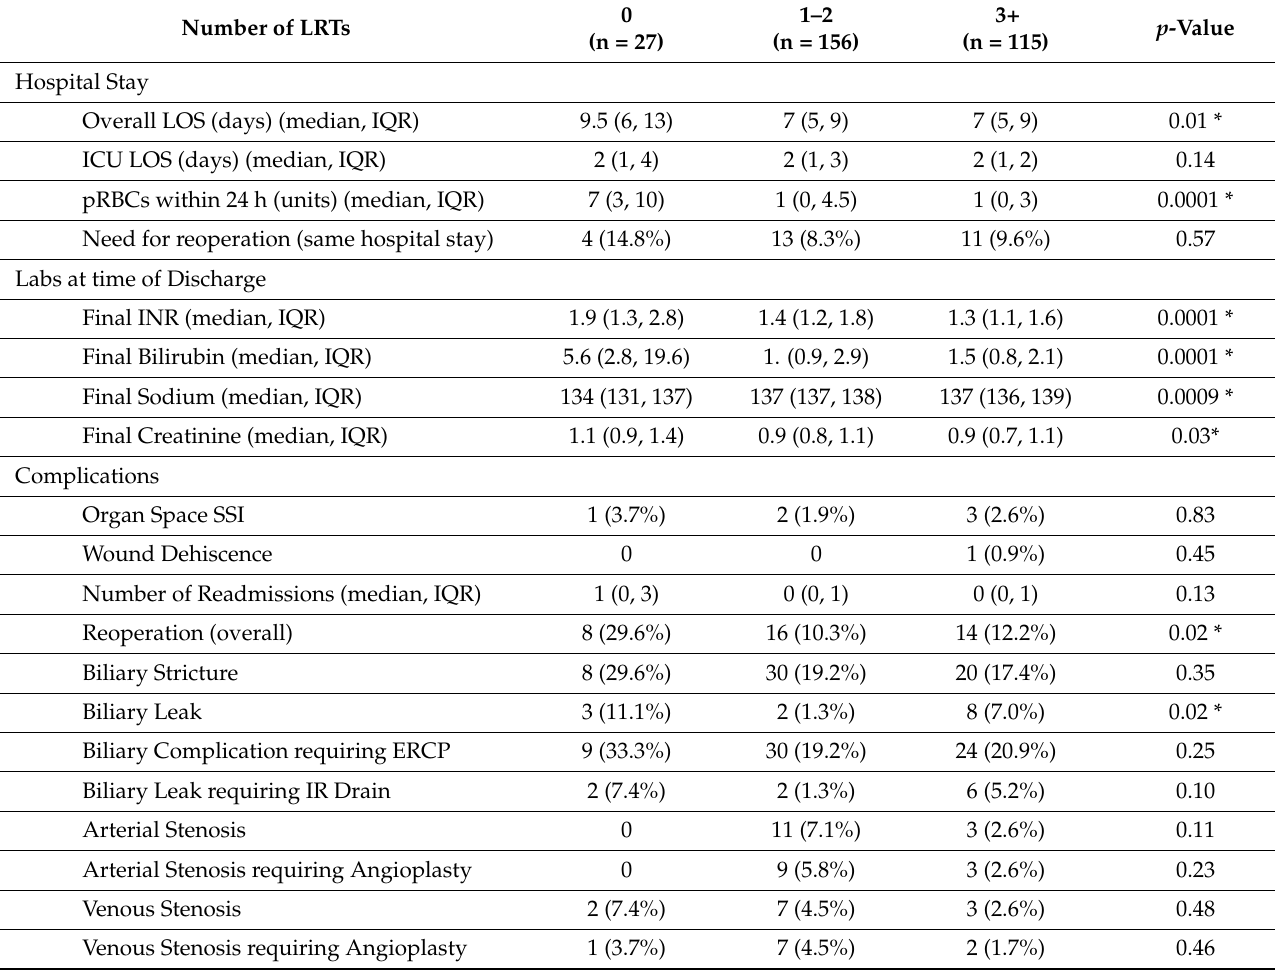
Table 3. Post-operative Measures Stratified by Total Number of LRTs.